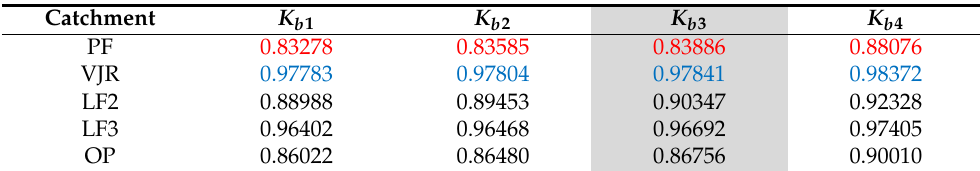
Table 4. Mean baseflow recession constants produced by various estimators ( K b 1 , K b 2 , K b 3 , and K b 4 ) in the different